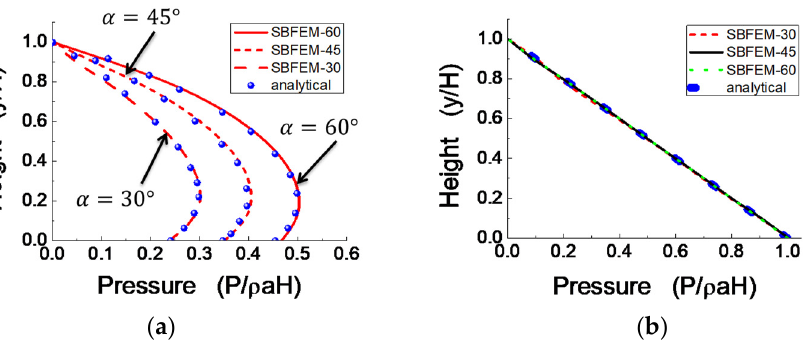
Figure 12. Rectangular valley: ( a ) upstream–downstream excitation and ( b ) vertical excitation.